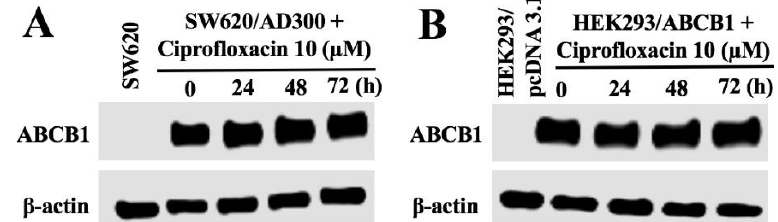
Figure 4. Effect of ciprofloxacin on the expression of ABCB1. The effect of ciprofloxacin on the expression of ABCB1 was tested after the cells were treated with 10 μM ciprofloxacin for 0, 24, 48, 72, and 96 h ( A , B ). Equal amounts of total cell lysates were used for each sample and a Western blot analysis was performed.